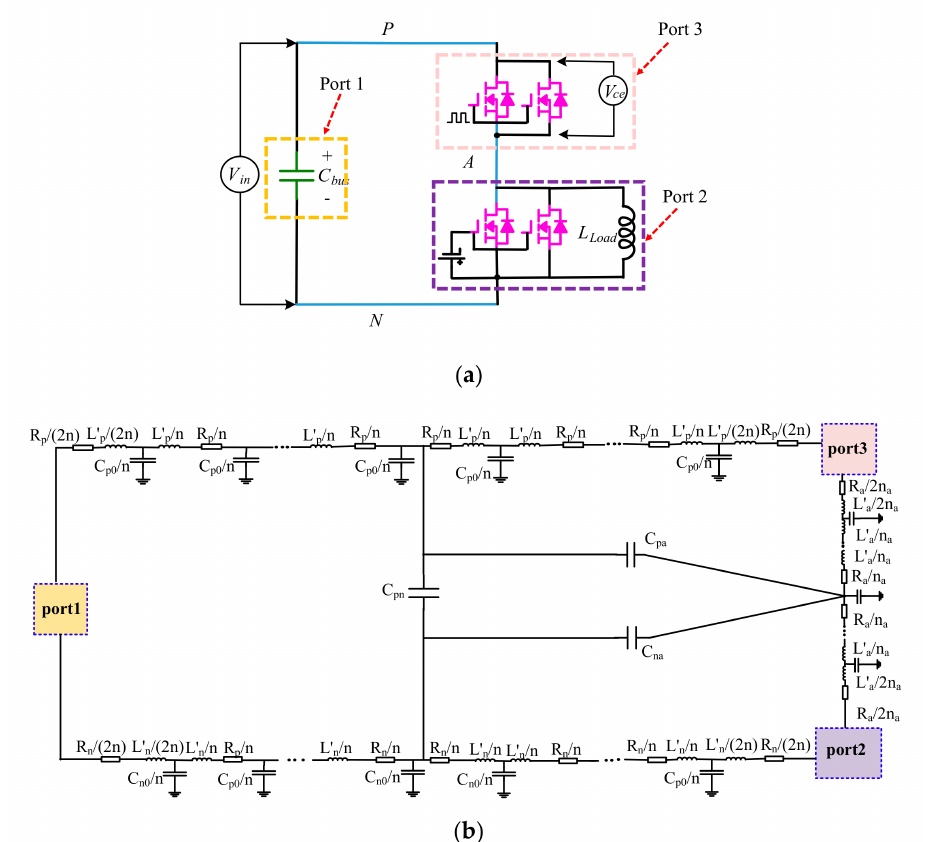
Figure 1. The current communication loop of prototype insulated-gate bipolar transistor (IGBT)-based inverter. ( a ) Schematic diagram of single-phase double pulse test circuit. ( b ) Full-order equivalent circuit